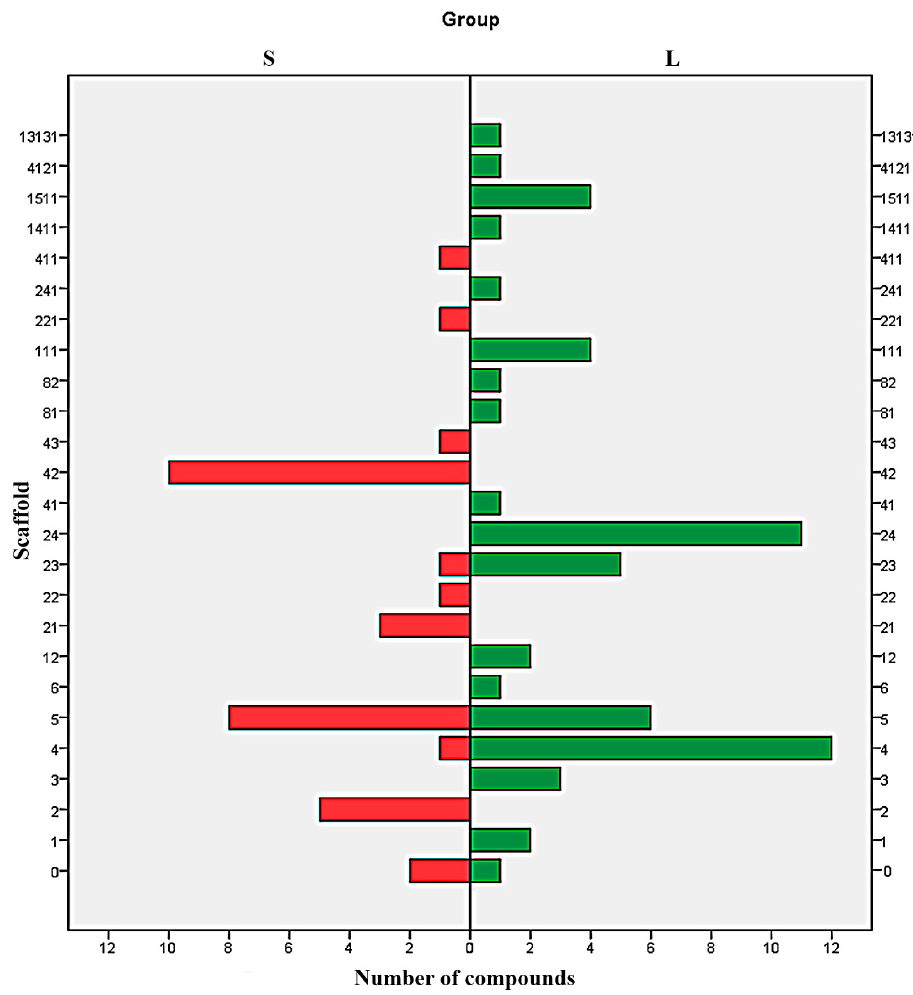
Figure 4. Parallel distribution of scaffolds in strong (S) and low (L) potency inhibitors